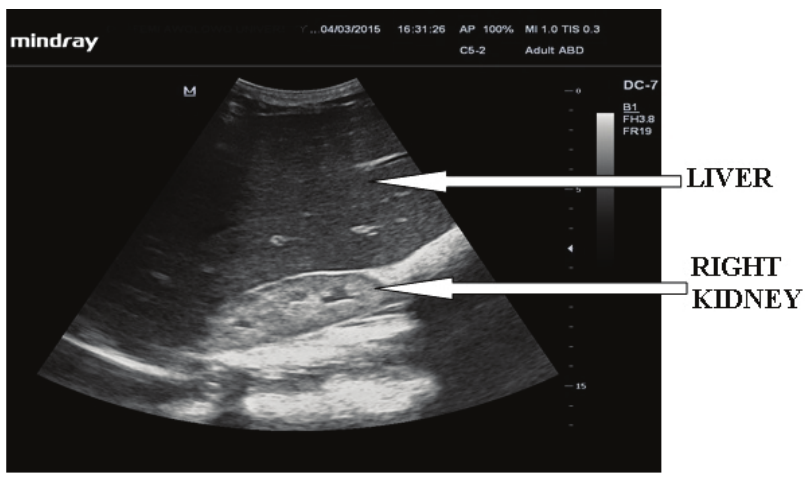
Figure 1: Sonogram showing massive hepatomegaly in a patient with sickle cell anemia (SCA). The lower lobe of the liver extends well below the lower pole of right kidney and the liver measures 22.3 cm in span exceeding the normal limit of 15.5